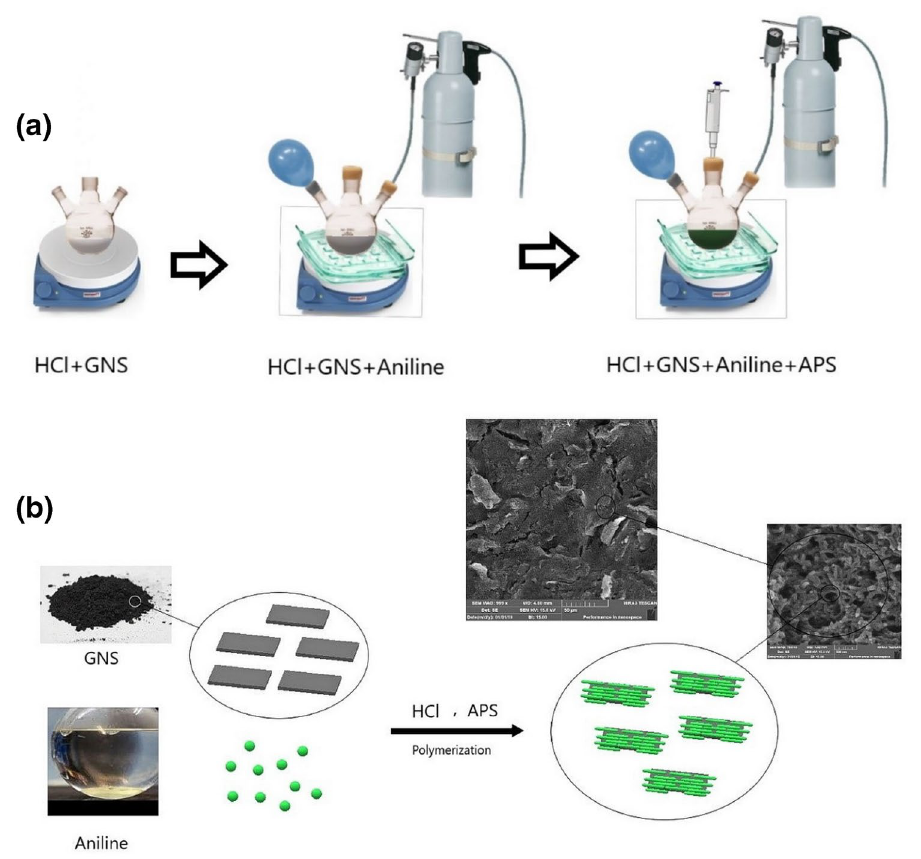
Fig. 1 a Schematic of nano- composite synthesis process. b Schematic of PANI/GNS com- posite nanoparticles